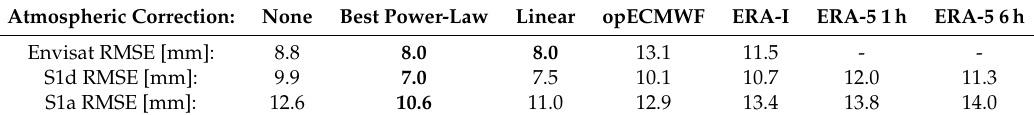
Table 4. Root mean square errors for different atmospheric correction techniques. ERA-5 data cover only the Sentinel-1 acquisition period and thus cannot be used for improving the Envisat time series. The best results are highlighted in bold. The area of main deformation (cf. Figure1) is excluded from this estimation.